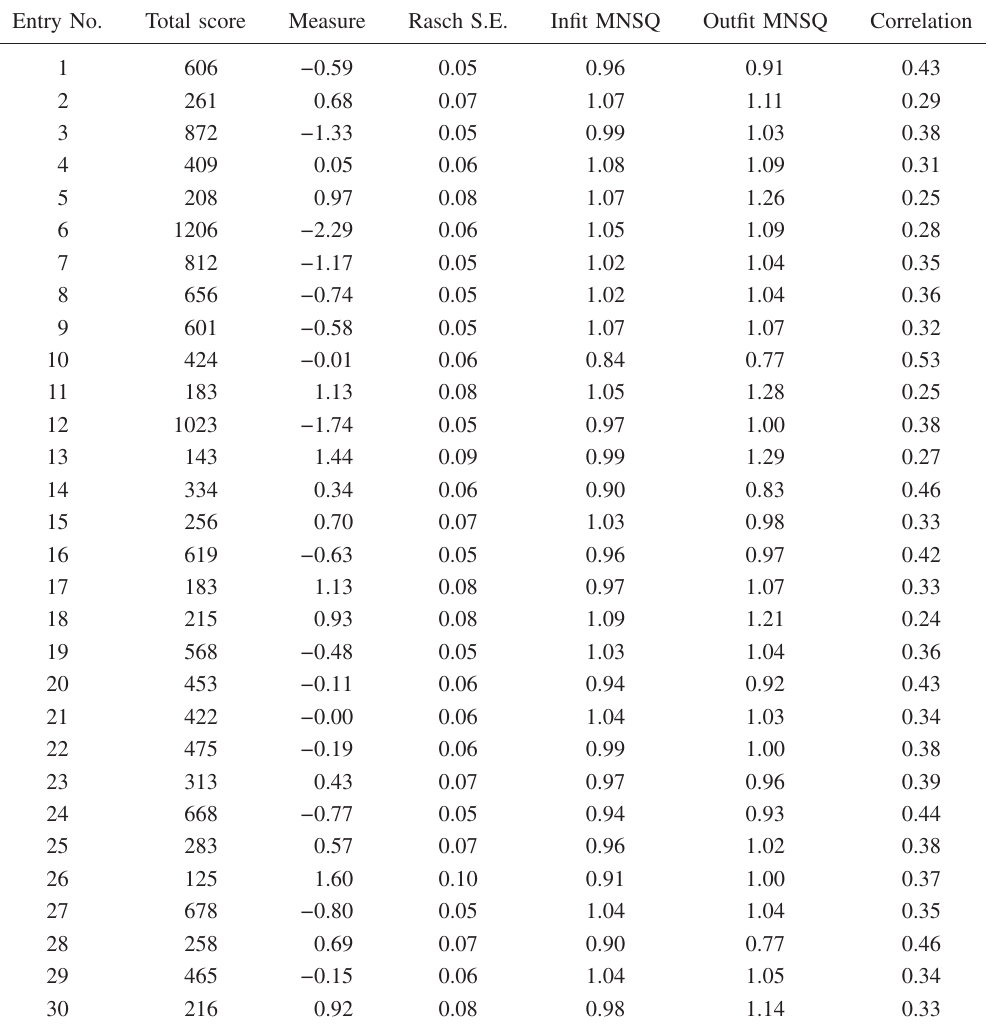
TABLE II. Statistical information for items for the Rasch analysis of the gymnasium sample. Displayed are total raw score, item measure in logit, Rasch standard error, infit and outfit MNSQ statistics, and point- measure correlation for each